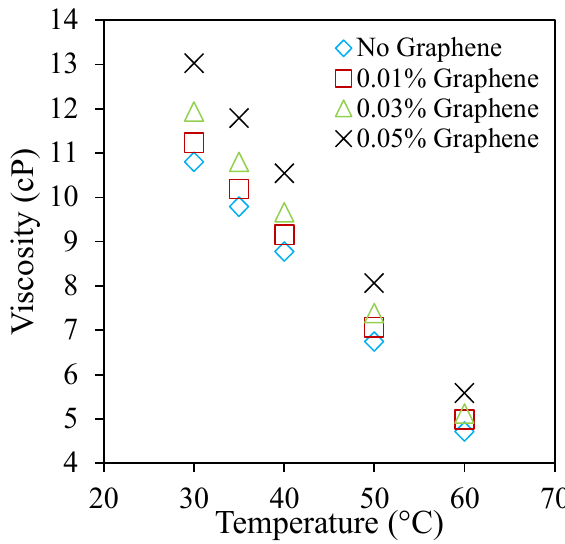
Figure 3. Variation of viscosity of graphene–transformer oil nanofluid with temperature.